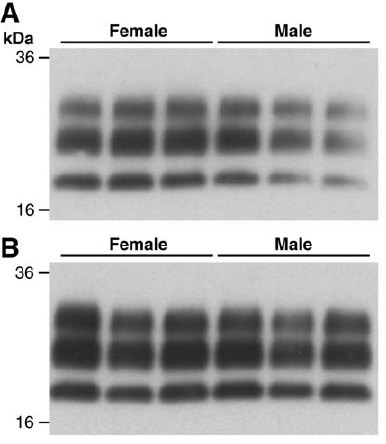
Figure 5. Western blot of PrP Sc from the brains of C57BL/6 and FVB/N mice following Chandler/RML transmission. Western blot of proteinase-K treated 10% w/v brain homogenates (n=3 for both males and females) immunoblotted with anti-PrP monoclonal antibody ICSM-35 (D-Gen Ltd, UK). (A) C57BL/6 mice (B) FVB mice. The PrP Sc from both male and female brains is characteristic of the RML scrapie prion strain and no sex differences are seen.